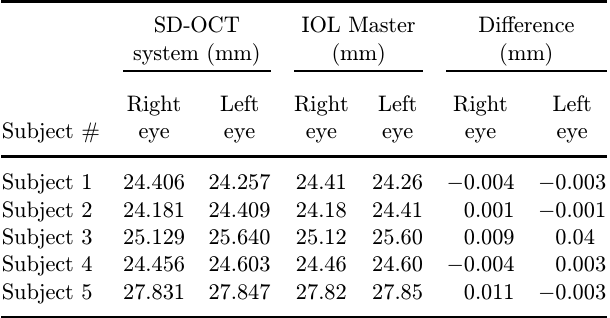
Table 1. Measurement of the myopic eye length in vivo with the SD-OCT system and with IOL